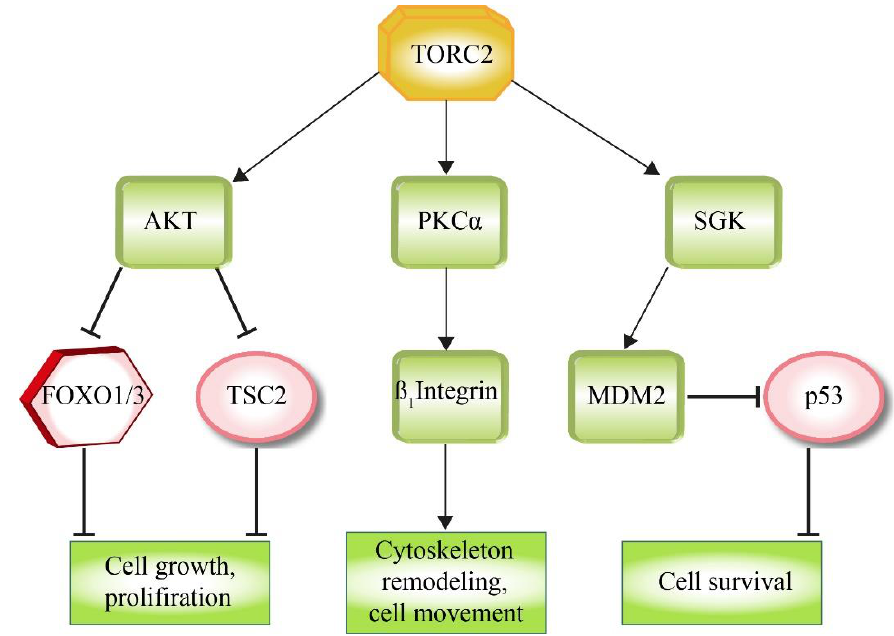
Figure 5. Downstream effectors of TORC2. The direct phosphorylation of the depicted kinases by TORC2 results in their activation. Factors that interfere with the aims of TORC2 (circles, hexagon) function are inactivated by phosphorylation, while supportive factors (squares) downstream of the TORC2 are stimulated by phosphorylation.